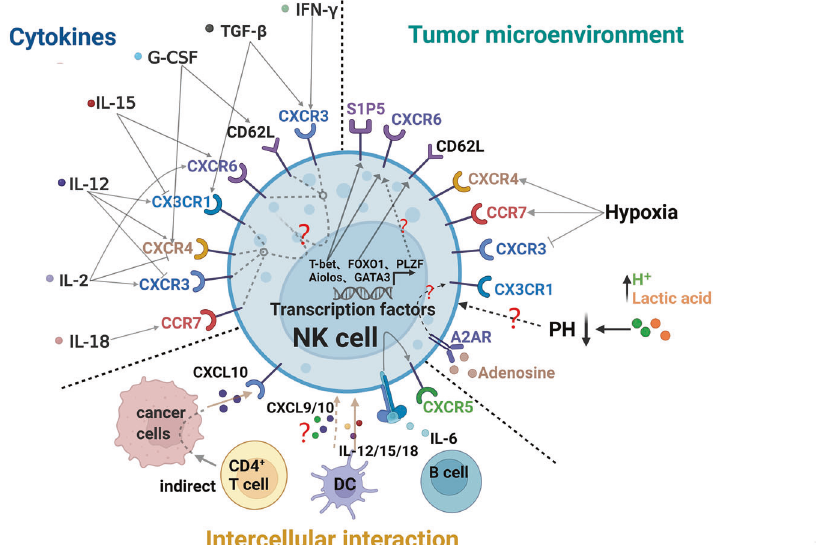
Fig. 5 Factors affecting NK cell traf fi cking and homing. Cell intrinsic factors (e.g., transcription factors), extrinsic factors (e.g., cytokines, hypoxia, low pH), and cell – cell interactions affect NK cell traf fi cking and homing in both healthy and tumor tissues. During NK cell development, some transcription factors cell-intrinsically regulate the expression of chemokine receptors, selectins, and integrins, etc., thus helping to regulate NK cell homing and traf fi cking in a cell-intrinsic manner. Cytokines and immune suppressive factors from the TME (e.g., hypoxia, low pH, and adenosine) can also sabotage the recruitment and homing of NK cells in speci fi c tissues by affecting the expression of chemokine receptors, selectins, and integrins on NK cells or their corresponding ligands in the TME. DCs, B cells, and CD4 + cells also affect the migration of NK cells via the chemokine – chemokine receptor axis. Created with